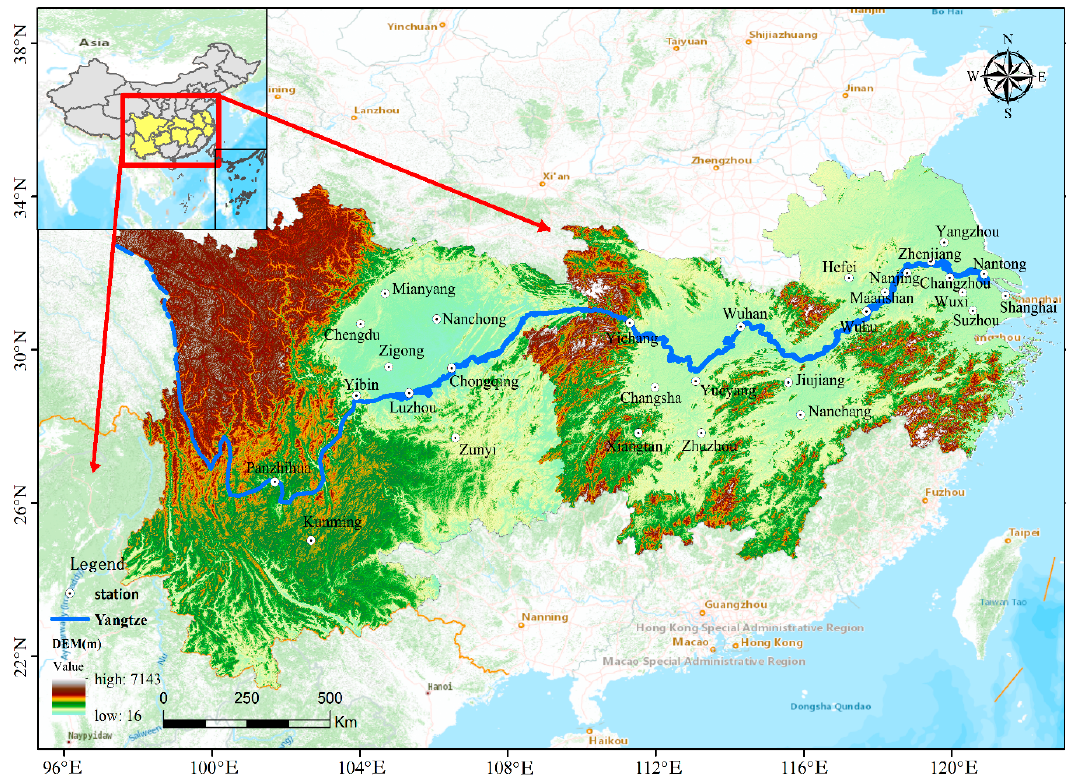
Figure 1. Location of the 29 cities in the Yangtze River Economic Belt (YREB) selected in this study. Yichang and Jiujiang are the boundary points between the upstream, midstream, and downstream of the YREB.